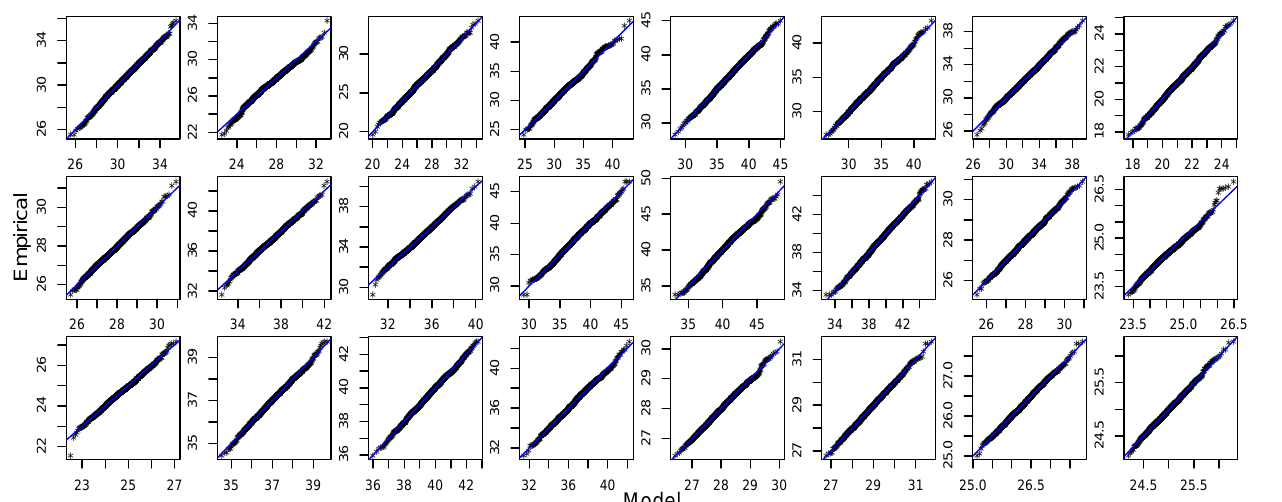
Figure C1. The Q–Q plots for the fitted GEVs of warm extremes in the model run simulating pre-industrial conditions. For clarity we display only every other row and column of the grid cells shown in Fig. 2.